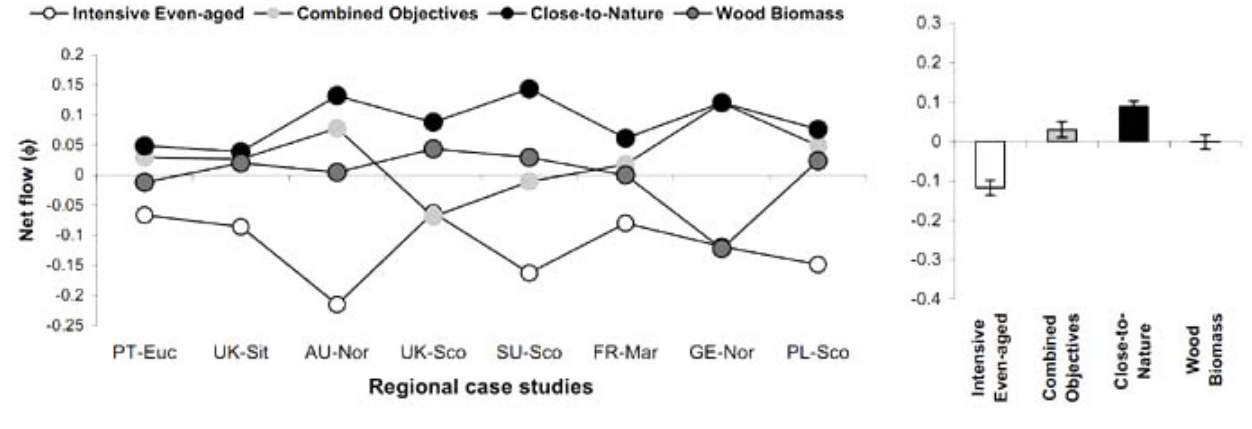
Fig. 4. Ranking of FMAs according to impact on risk of damage, giving more importance (“uneven importance” test) to tree mortality than tree growth loss and wood quality loss, across eight different regional case studies (left-hand side) and for overall results (right-hand